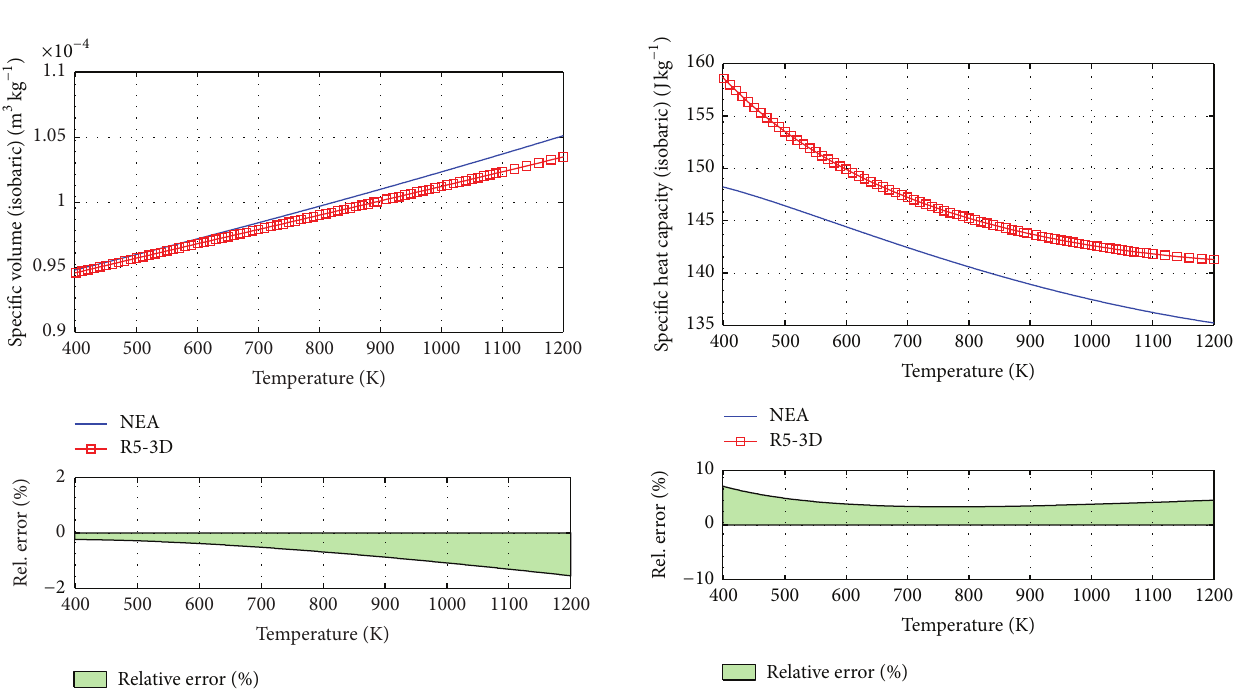
Figure 3: LBE liquid specific heat at constant pressure, original R5- 3D “tpf” file versus NEA